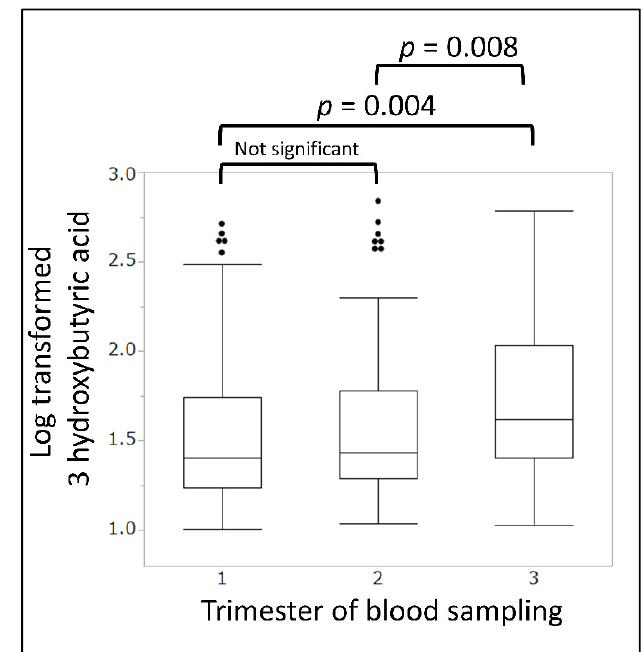
Figure 2. Median 3-hydroxybutyric acid levels in the group without the glucose challenge test dur- ing pregnancy. during